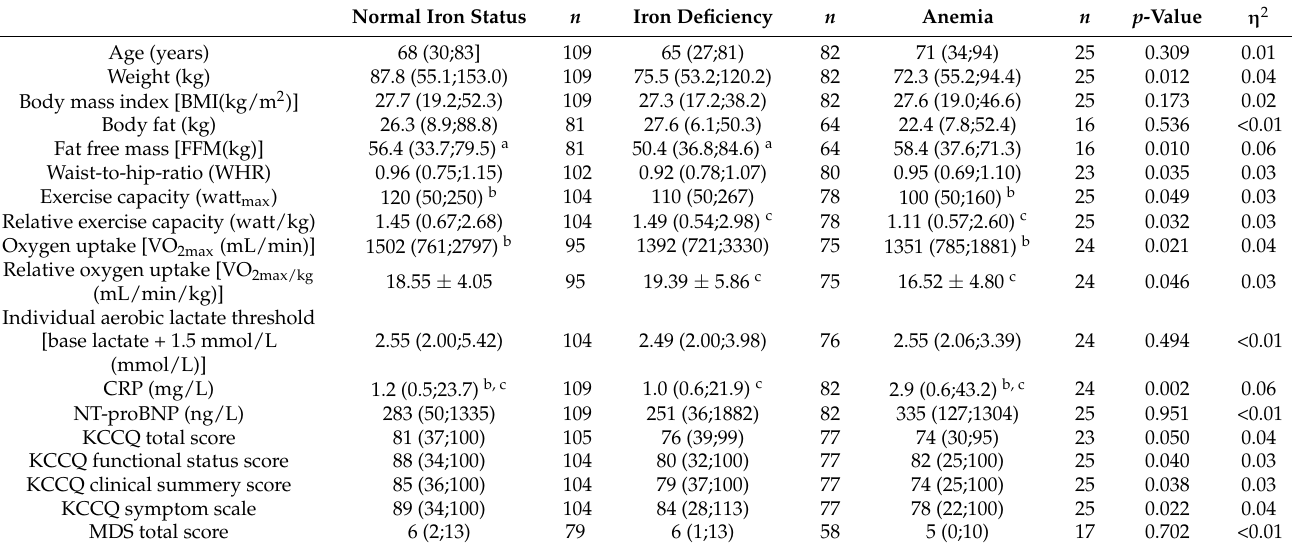
Table 3. ANOVA Results of the subgroups for iron